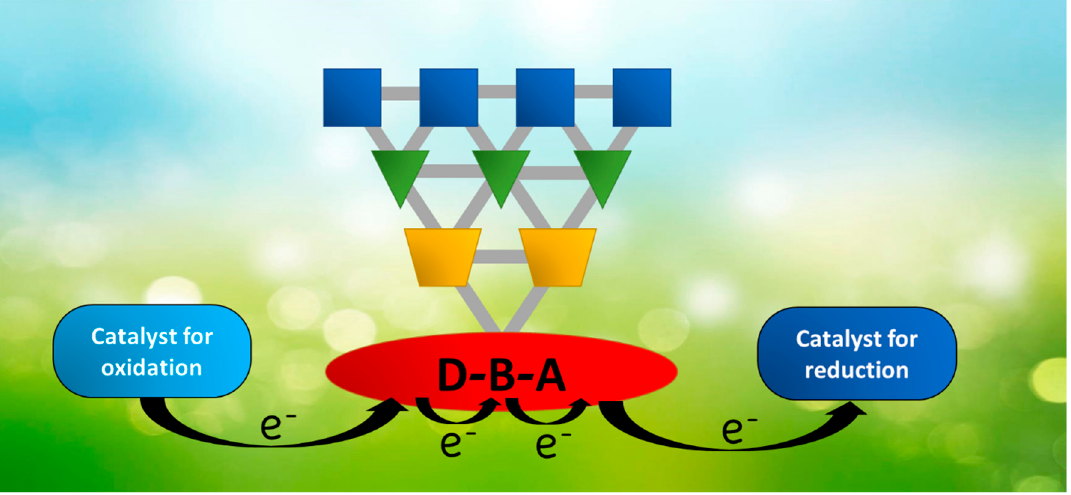
Figure 1. Schematization of an artificial photosynthetic system. The blue squares, green triangles, and orange pentagons constitute the antenna system; the red D-B-A subunit is the reaction center system.